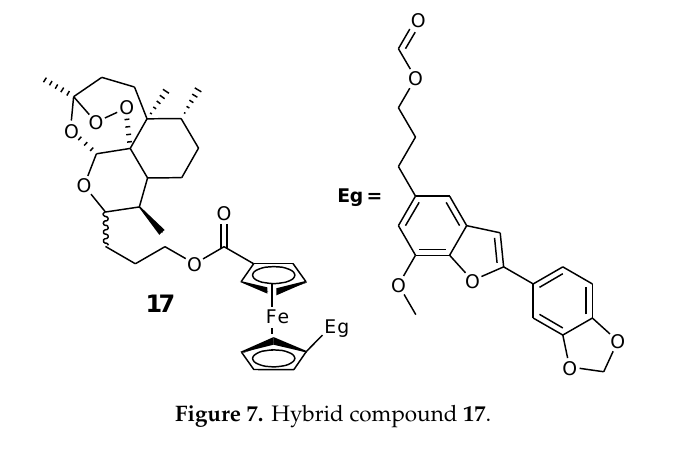
Figure 7. Hybrid compound 17 .